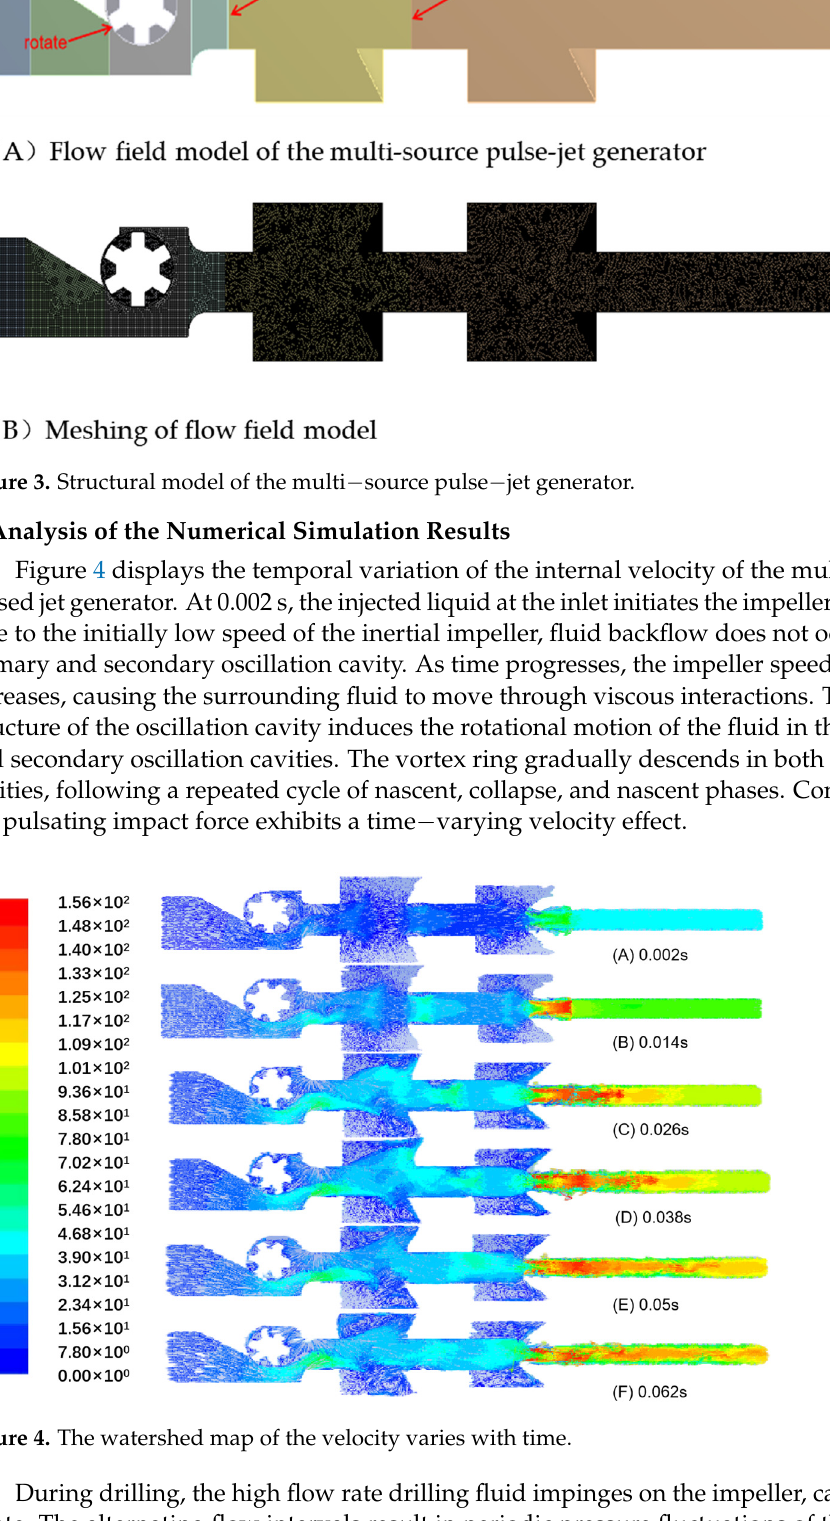
Figure 4. The watershed map of the velocity varies with time.